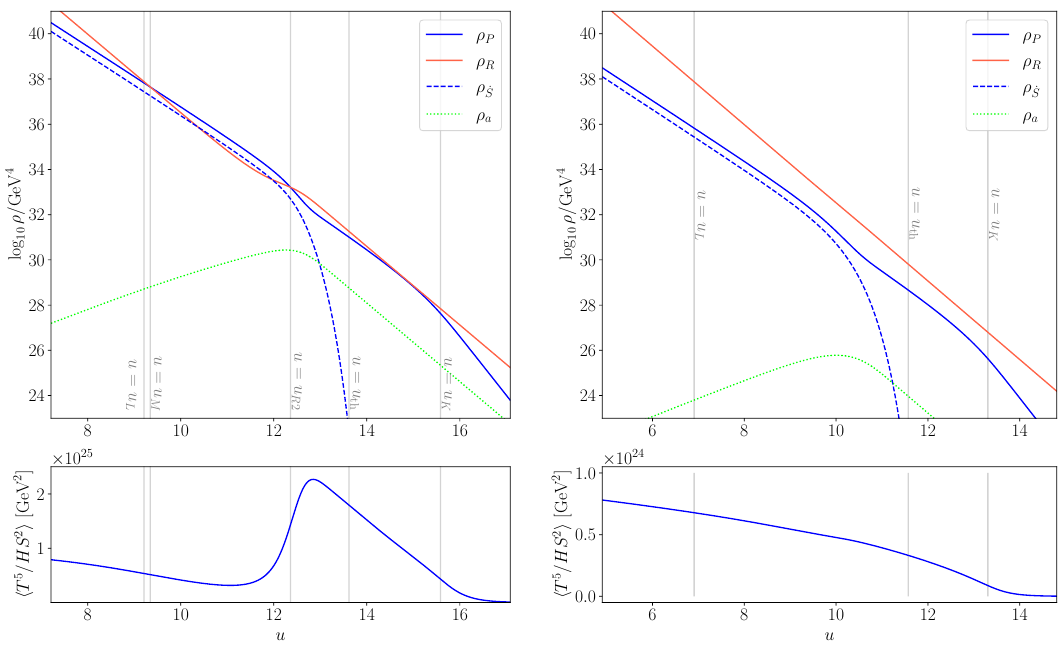
Figure 3 . The evolution of the energy densities of the PQ field (blue solid), radiation (red), radial direction (blue dashed) and axion (green dotted). n = 10 , θ and m = 10 6 GeV in the left panel, and n = 8 , θ P m P = 10 5 GeV in the right panel. The lower panels show the baryon